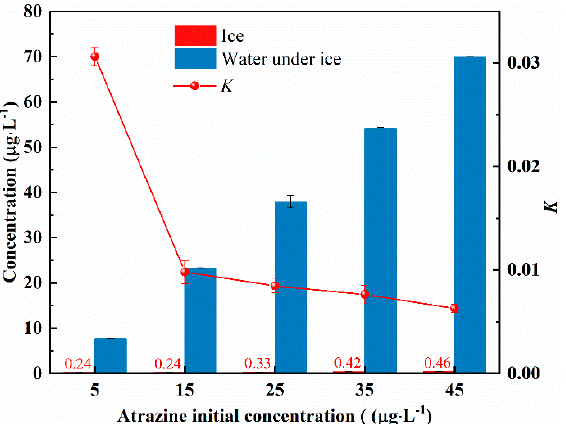
Figure 4. Ice-water distribution of atrazine at different initial concentrations.